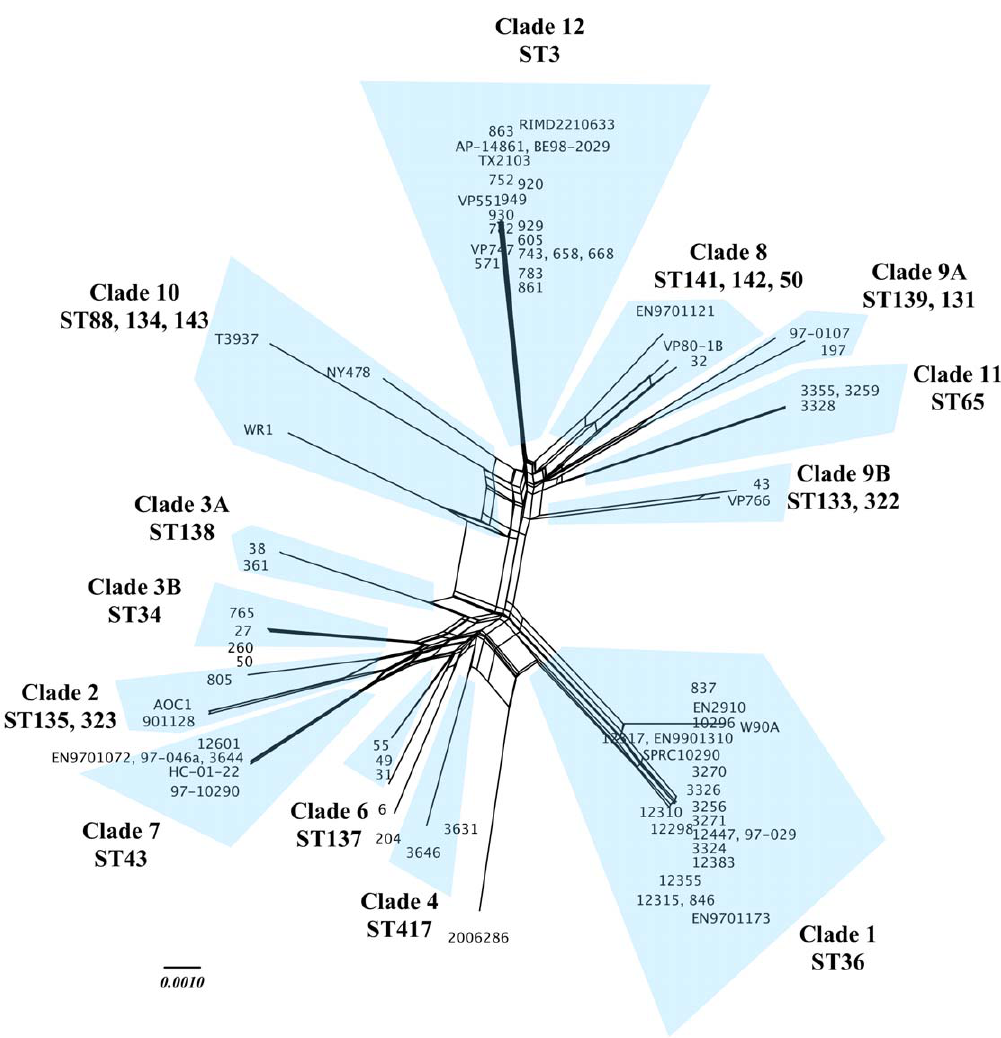
Figure 3. NeighborNet analysis. SplitsTree v4 NeigborNet analysis of 77 V. parahaemolyticus isolates based on 7 concatenated housekeeping loci ( dna E, gyr B, rec A, dtd S, pnt A, pry C and tna A) representing a total 3,682 nucleotides. Sequence typing (ST) designations for MLST analysis and phylogenetic clades (1–12) included for reference. Regions of the network showing extensive reticulation (e.g., clades 8 and 10), consistent with higher rates of recombination, contrast with the less reticulated nature of clade 12. Highlights in blue distinguish groups of isolates sharing ST and clade designations and function to facilitate comparison with Figure 2.